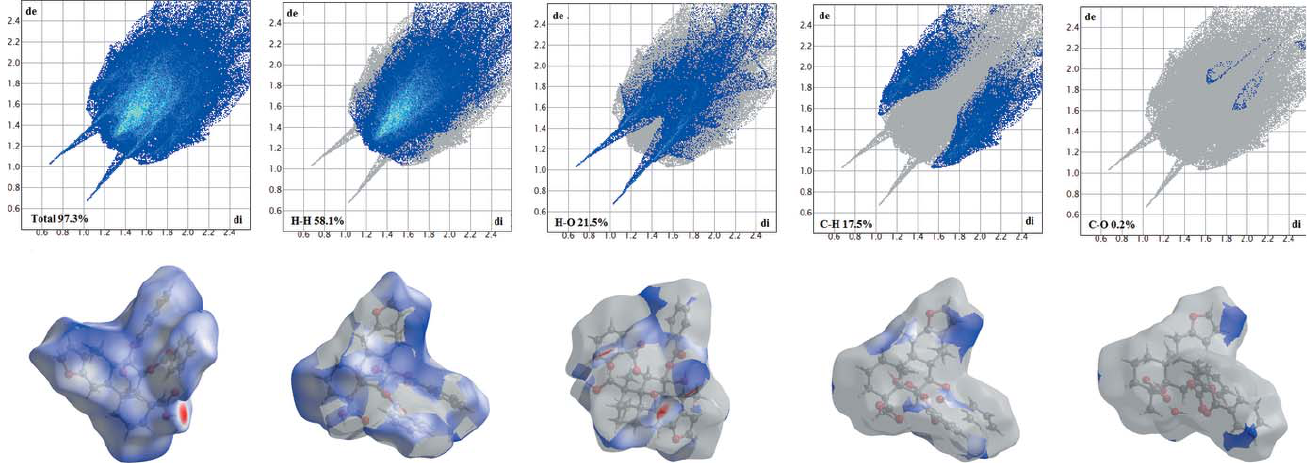
Figure 6 Two-dimensional fingerprint plots for the title compound together with areas of Hirshfeld surfaces involved in hydrogen bonding.